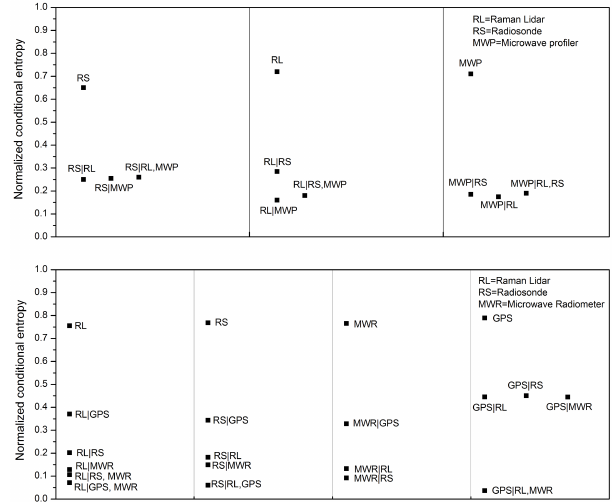
Figure 8. Comparison of the normalized conditional entropy values retrieved for most of the possible combinations of instruments mea- suring integrated water vapour at the Potenza site (upper panel) and the Southern Great Plains site (bottom